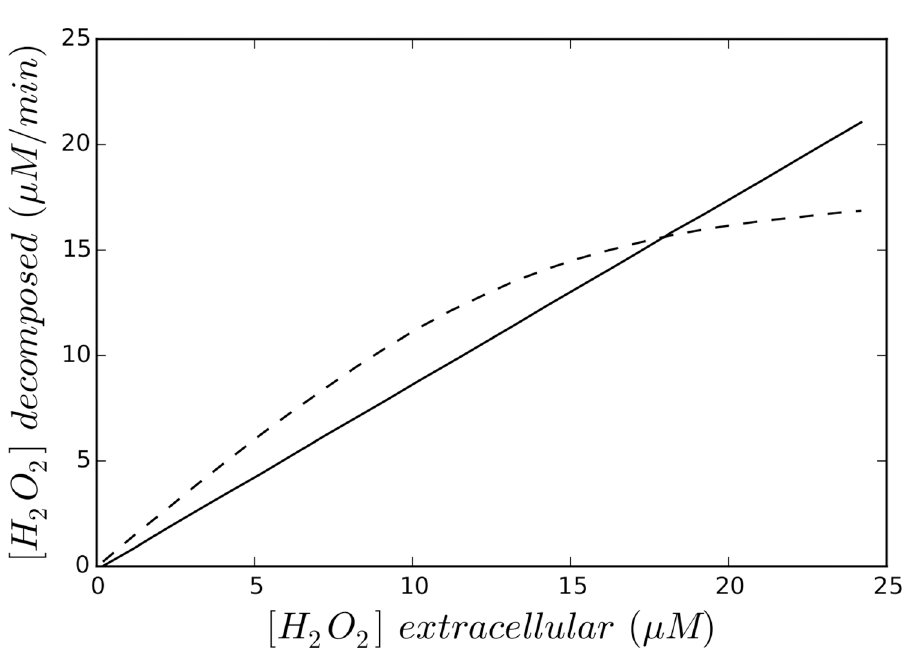
Fig 5. Kinetics of exogenous H 2 O 2 decomposition for 1.5 × 10 8 E. coli cells ml − 1 . The dotted line corresponds to the Cat(-) mutant and solid line corresponds to the Ahp (-) mutant (higher magnification for Fig